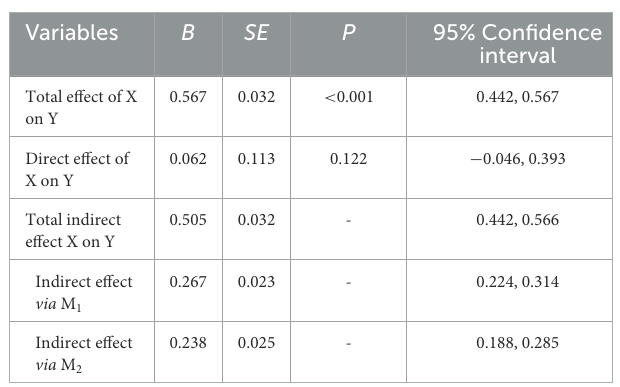
TABLE 3 Total, direct, and indirect effect